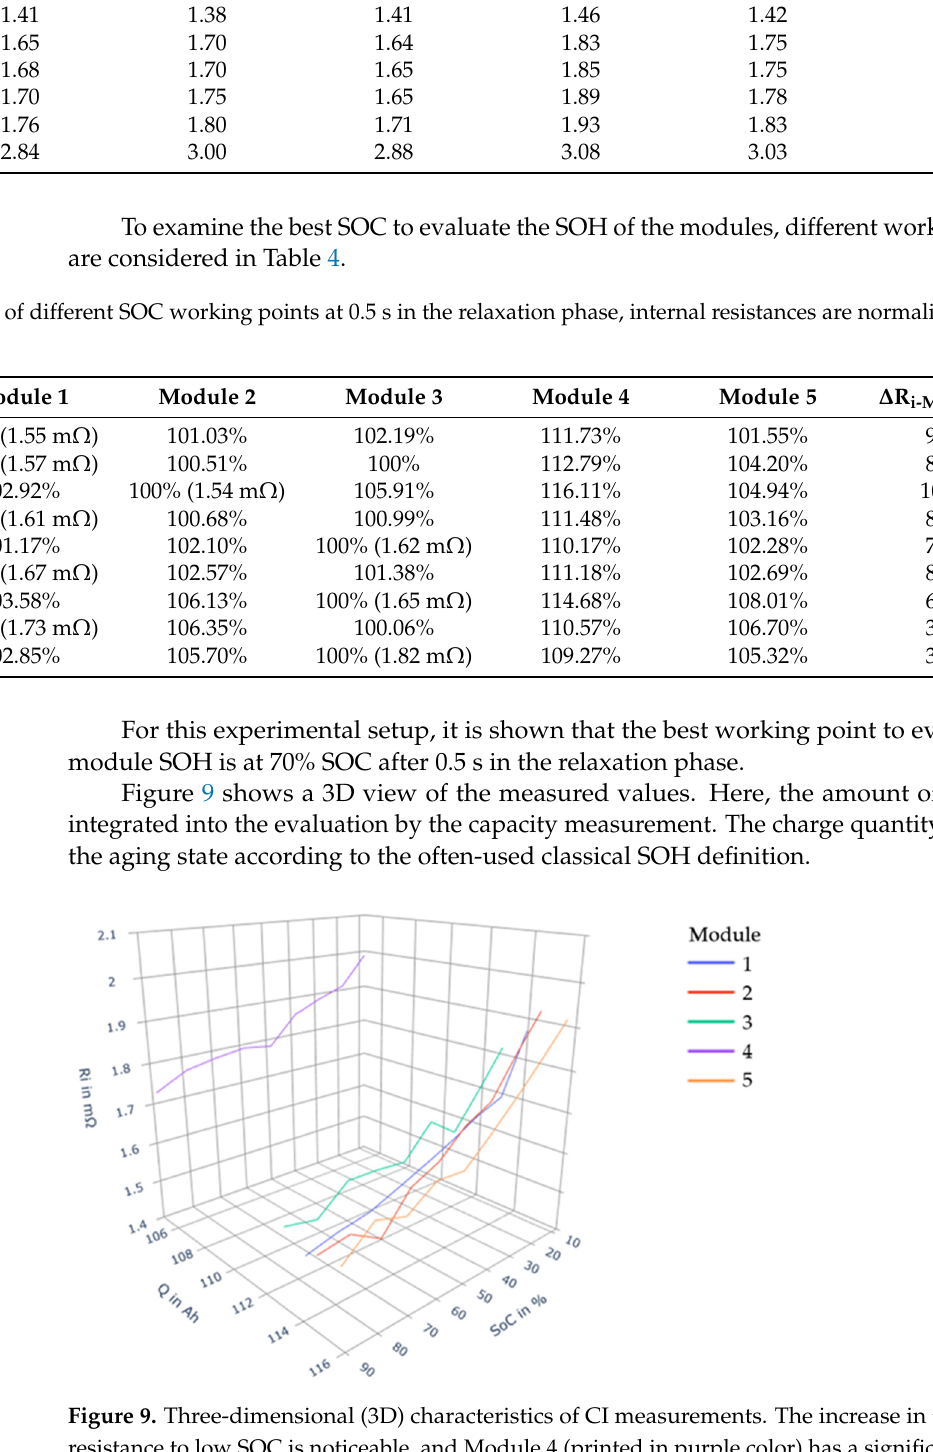
Table 3. Comparison of internal resistances at different time points, measured in the relaxation phase at 30% SOC with the CI method.